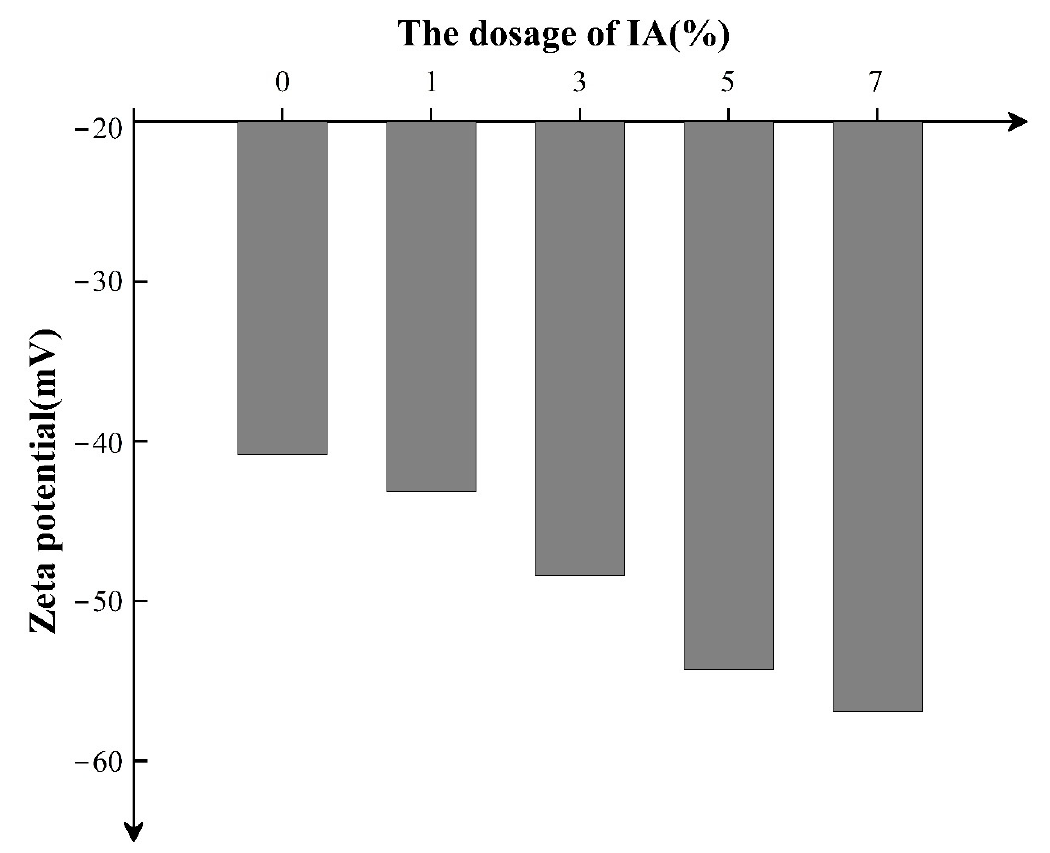
Figure 5. Zeta potential of SISBR latex at various dosages of